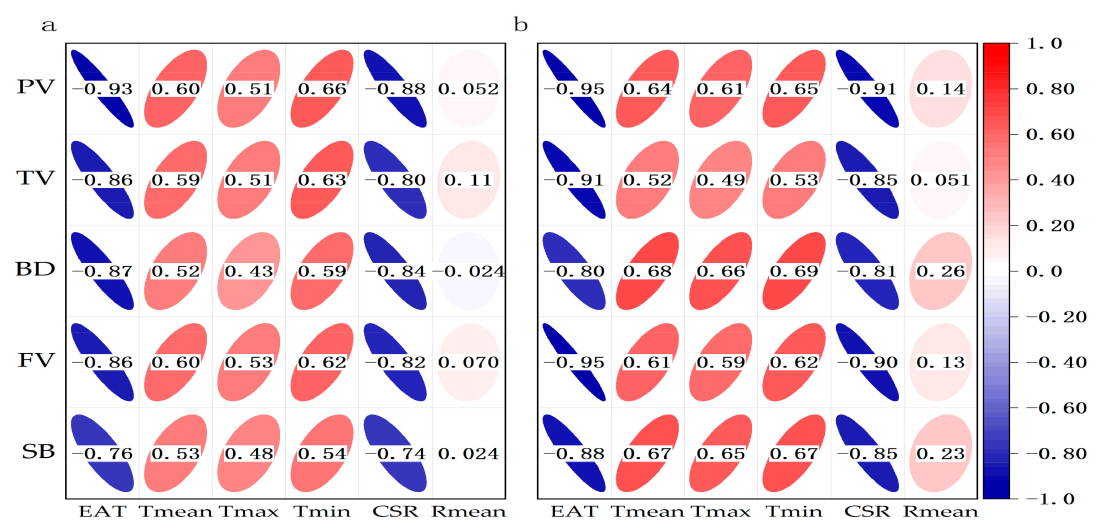
Figure 11. Correlation of different post-anthesis temperatures and radiation on starch gelatinization properties of wheat. ( a ): 2017–2018, ( b ): 2018–2019; EAT: effective accumulated temperature, T mean :